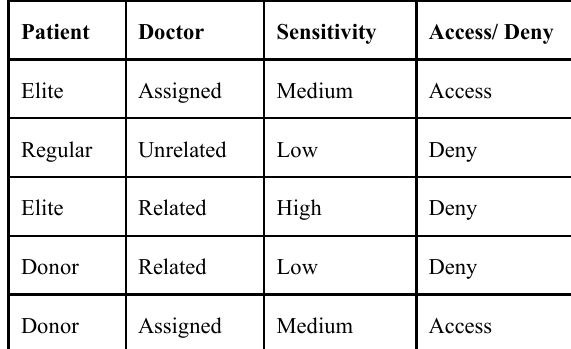
Table 6. Sample of